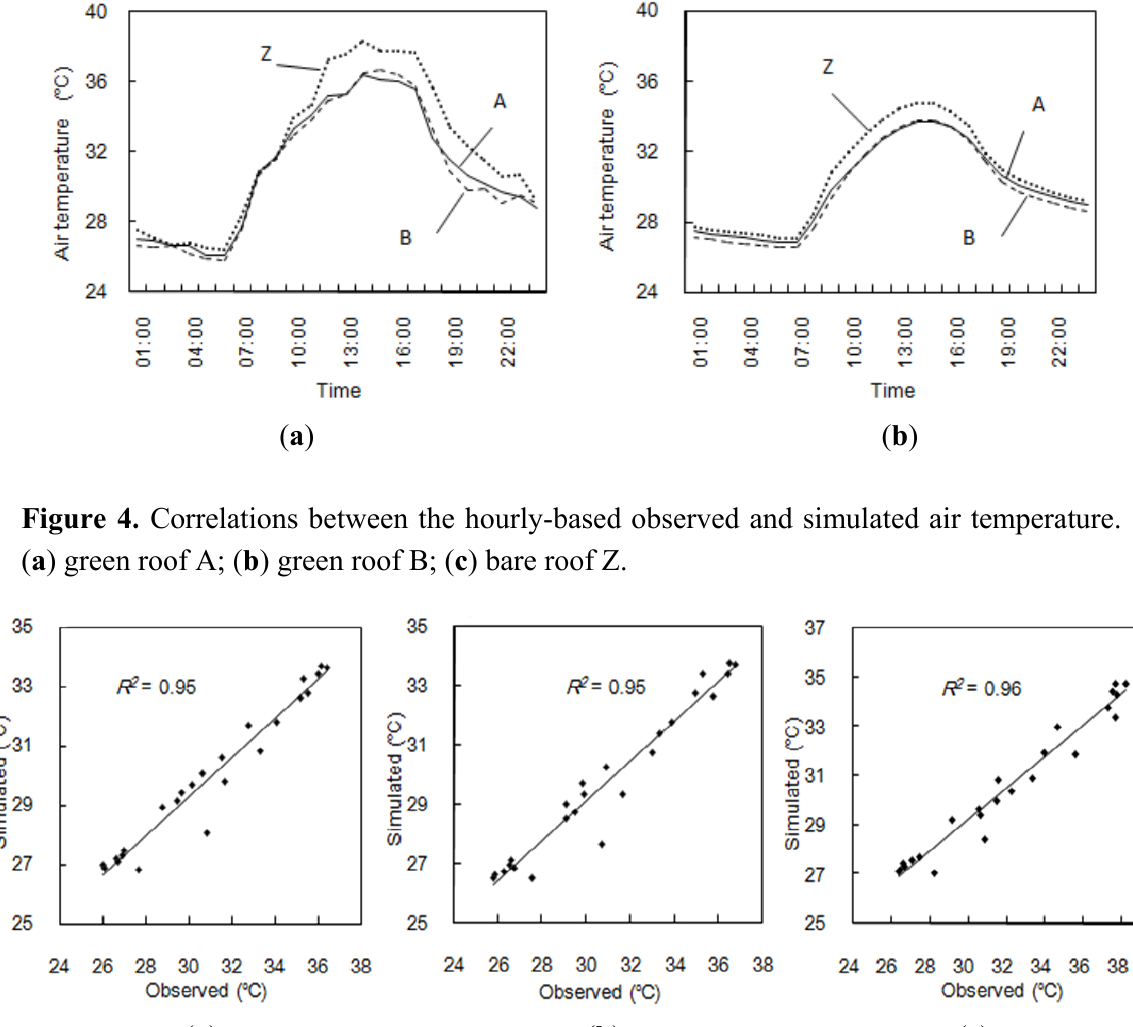
Figure 3. Horizontal pattern of diurnal air temperature: ( a ) observed; ( b) simulated. (lines A, B, and Z respectively denote the two green roofs and the bare roof).